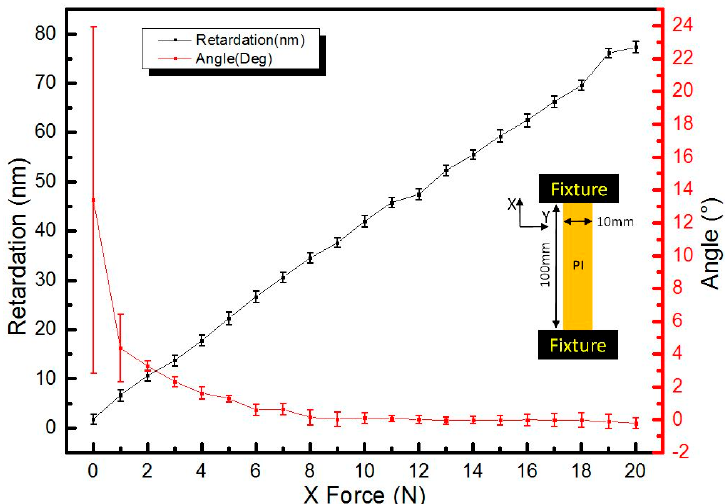
Figure 5. Stress birefringence of PI membrane in uniaxial tension mode, where the black line stands for the retardation value against the axial stretching force and the red line represents the retardation angle against the axial stretching force.